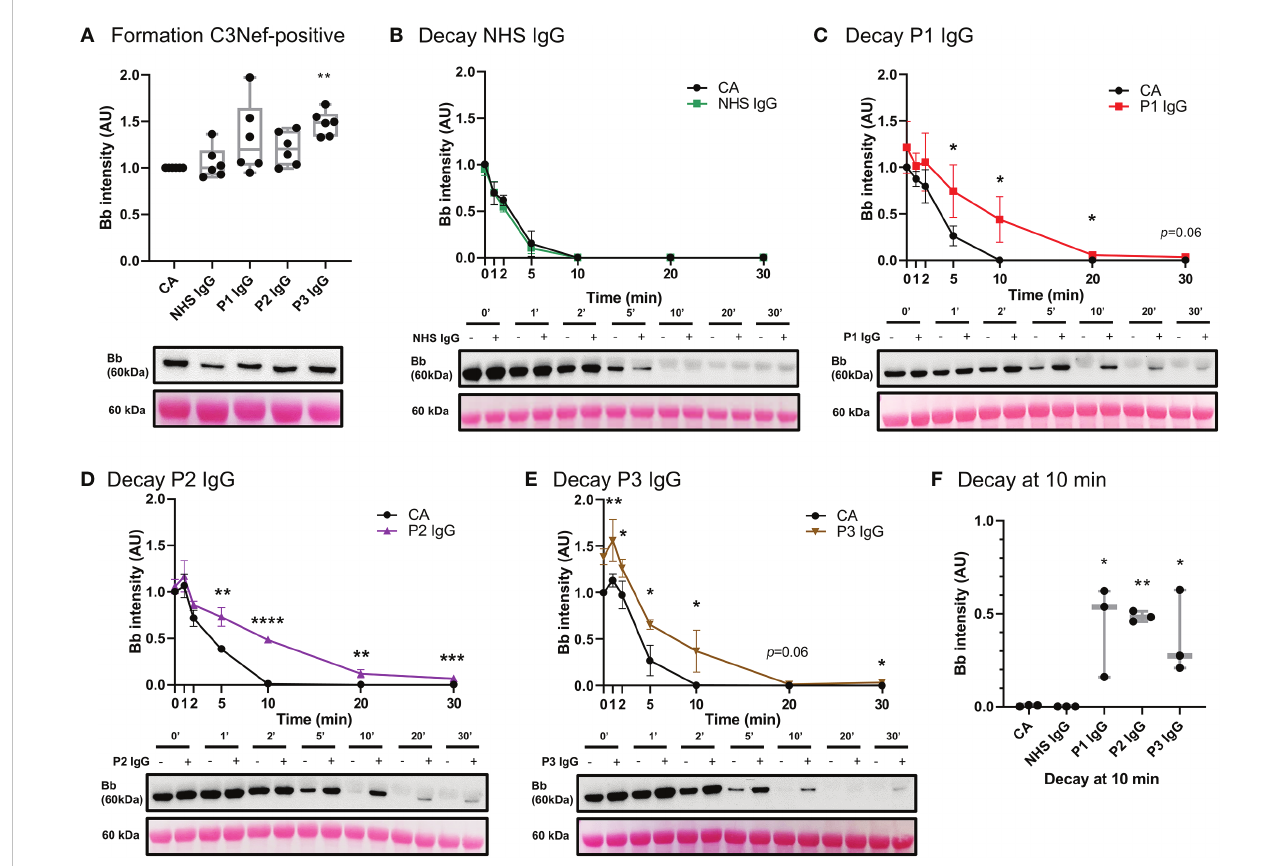
FIGURE 7 IgG from C3Nef+ C3G patients stabilize C3 convertase and decrease its decay rate. (A) Western blot analysis of CA formed alone, or in presence of NHS, P1, P2 or P3 IgG. P3 IgG signi fi cantly increases C3bBb formation. Results were normalized to CA and presented as relative protein expression. Box plots show median, 1 st and 3 rd quartile ranges, and the individual data points of six independent experiments. Signi fi cance calculated for NHS IgG. (B) Western blot analysis showing C3 convertase formed alone ( CA) or in presence of NHS IgG, then decayed for up to 30 min. NHS IgG do not stabilize C3 convertase (NHS IgG t 1/2 = 3 min , CA t 1/2 = 3.36 min ). (C – E) Western blot analyses showing C3 convertase formed alone (CA) or in presence of IgG derived from C3Nef+ patients, then decayed for up to 30 min. (C) P1 IgG stabilizes C3bBb 2-fold (P1 t 1/2 = 8.9 min , CA t 1/2 = 4.3min). (D) P2 IgG stabilizes C3bBb 1.9-fold (P2 t 1/2 = 9.4 min , CA t 1/2 = 4.9 min ). (E) P3 IgG stabilizes C3bBb 1.7-fold (P3 t 1/2 = 8.7 min CA t 1/2 = 5 min ). Mean±SD of three independent experiments. Statistical signi fi cance shown for comparisons between CA/Patient IgG at the same timepoint. (F) Composite box plots showing C3 convertase stabilization by IgG from C3Nef+ C3G patients after 10 min of decay in buffer. For all decay experiments, results were normalized to CA at 0 min and presented as relative protein expression. Ponceau S Staining was used as a measure of total protein load. Box plots show median, and the individual data points of three independent experiments. Signi fi cance calculated for NHS IgG at 10 min. * P ≤ 0.05, ** P ≤ 0.01, *** P ≤ 0.001, **** P ≤